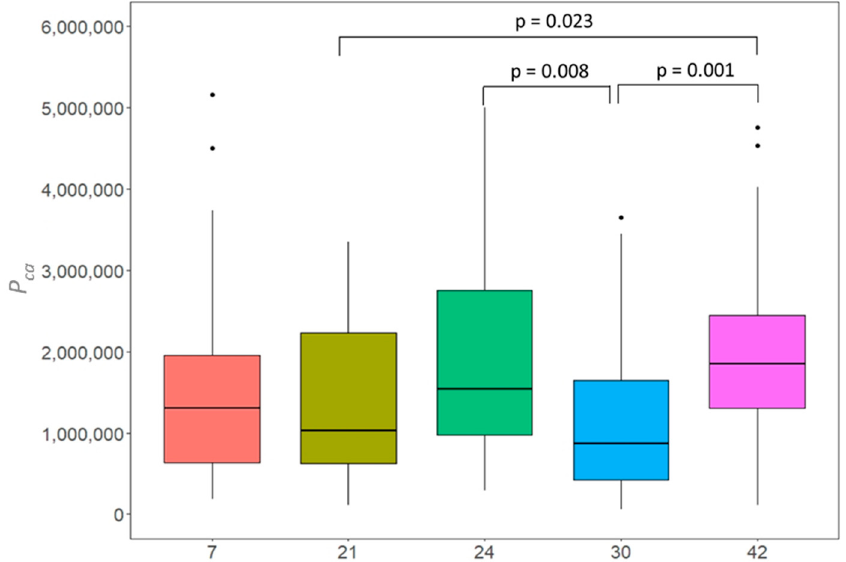
Figure 6. Boxplots based on pollen production per catkin ( P ca ) (eight replications per tree) estimated for five selected clones with at least two non-topped trees in the seed plantation in Wildberg for 2019, 2020 and 2021. Clones 7 and 21 consist of three trees each. Clone 24, 30 and 42 consist of two trees each. The interquartile range is represented by the height of the boxes, maximum and minimum values by the upper and lower whiskers, the median by bold horizontal lines in the boxes, points indicate outliers, lines above boxplots indicate pair of clones, which were significantly different (Kruskal–Wallis test and Dunn’s multiple comparison’s tests).